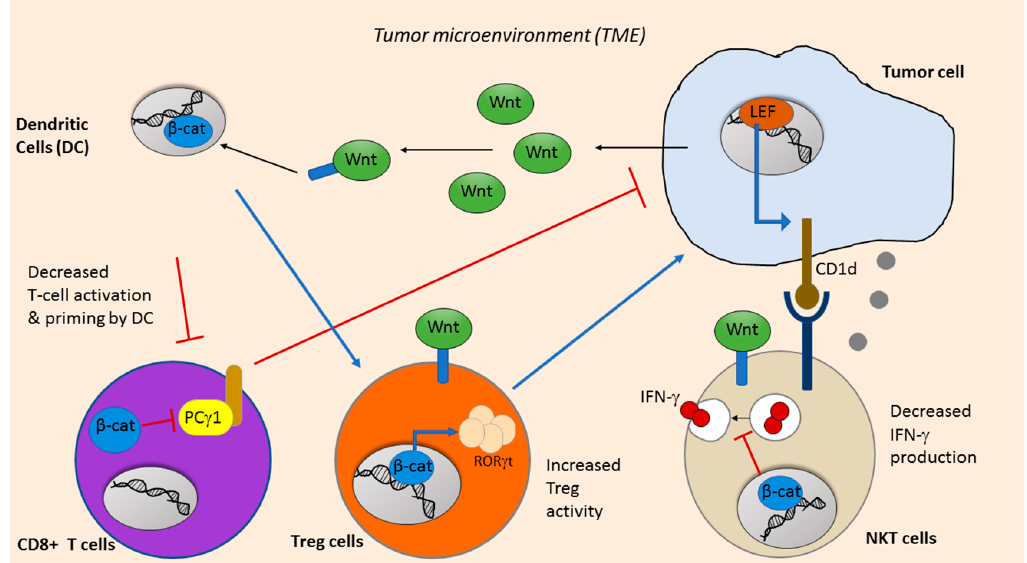
Figure 3. General schematic of Wnt signaling in tumor induced immunosuppression. Wnt ligands released by the tumor cells in the microenvironment influence dendritic cell (DC) function and chemokine release, which, in turn, suppresses priming and activation of CD8 + cytotoxic T-cells and prevents their anti-cancer action. β -catenin in CD8 + T cells decreases phospholipase C- γ 1 (PC γ 1)